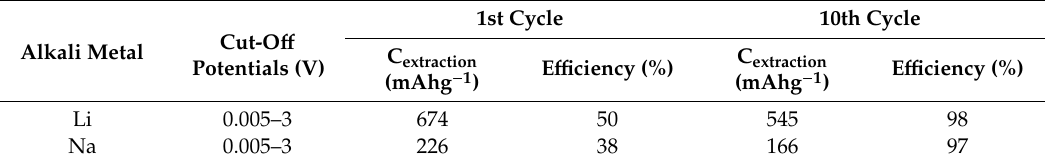
Figure 6. First two galvanostatic charge / discharge curves for BPO-C half-cell measurements against ( a ) lithium and ( b ) sodium. A specific current of 50 mAg − 1 was used. Lower and upper cut-o ff potentials were set to 0.005 and 3 V, respectively. The active material loading was around 1.3 mgcm − 2 . As electrolyte, either 1 M LiPF 6 in EC / DMC or 1 M NaClO 4 in propylene carbonate were applied. Table 2. Electrochemical data for BPO and BPO-C at a specific current of 50 mAg −